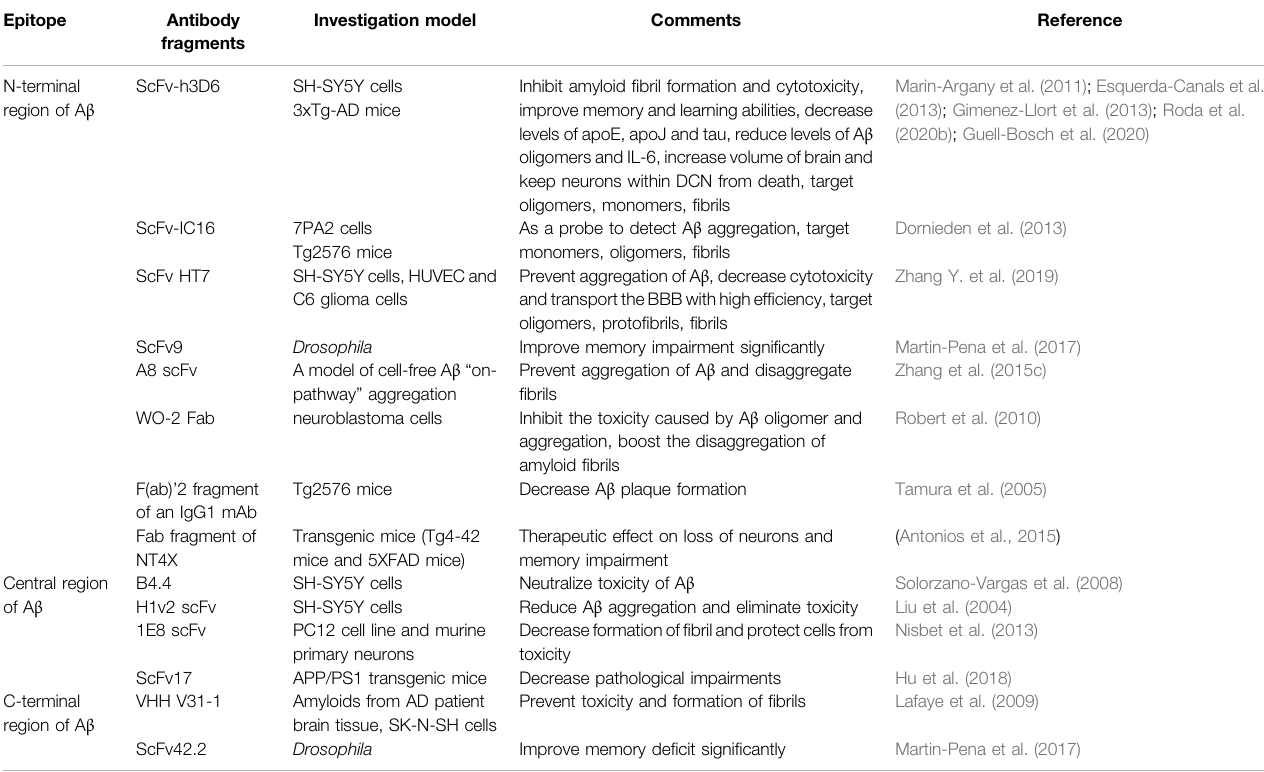
TABLE 1 | Antibody fragments against different epitopes of A β in AD. Epitope Antibody